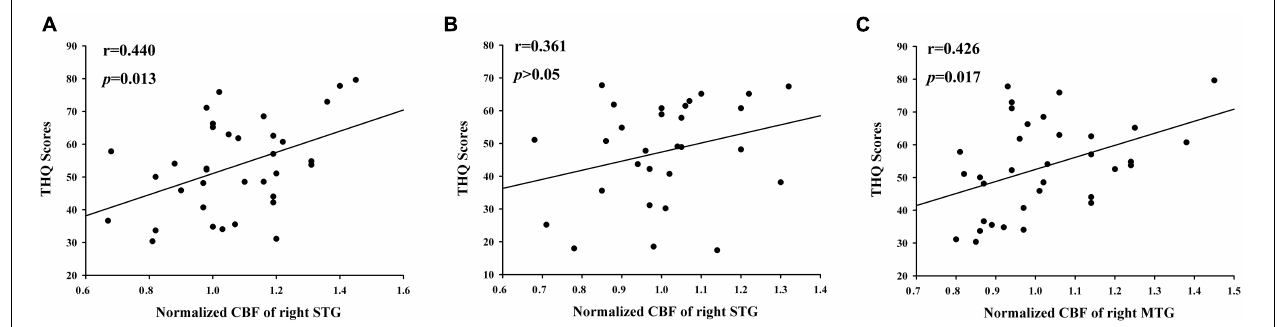
FIGURE 4 | The significant correlations between the CBF changes and the tinnitus characteristics. The THQ score was positively correlated with the normalized z-CBF of the right STG in chronic tinnitus patients ( r = 0.440, p = 0.013) (A) , but not in acute tinnitus patients ( r = 0.361, p > 0.05) (B) . Compared with HC, the THQ score was positively correlated with the normalized z-CBF of the right MTG in chronic tinnitus patients ( r = 0.426, p = 0.017) (C)